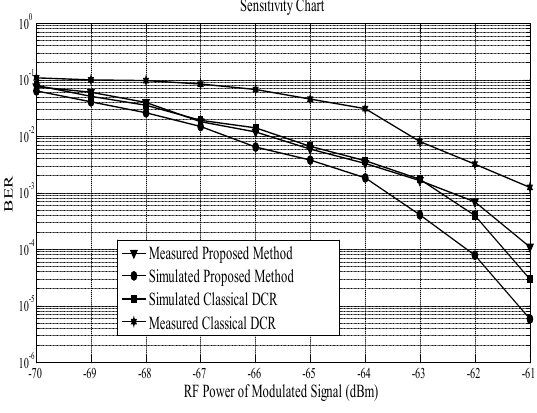
Figure 8 p resents t he s ensitivity measurement o f t he receiver. S ensitivity is t he minimum R F i nput p ower required t o e nsure re quired B ER. If re quired B ER i s assumed to 10-3, then the measured sensitivity of proposed method is -62.5 dBm, while that of classical DCR is -60.8 dBm.